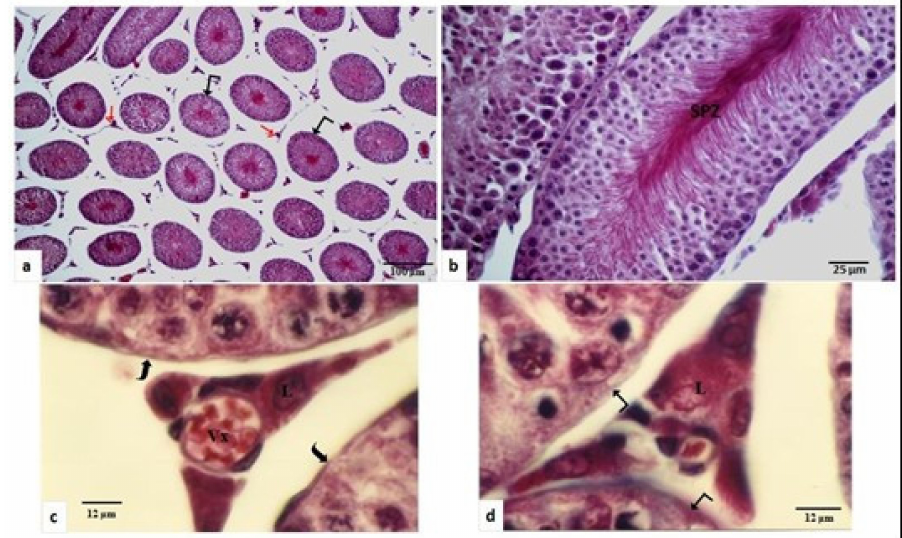
Figure 1. Testicular structure of Meriones libycus in the breeding period (spring and early summer). ( a ) Seminiferous tubules diameter ( ) is high (700 μ m ± 806 μ m) with regular outline Leyding cells ( ) are observed in the inter-tubular space. ( b ) The spermatogenesis is very active and numerous spermatozoa (SPZ) are accumulated in the lumen of the seminiferous tubule. ( c ) Leydig cells (L) are large and arranged around blood vessels (Vx), and the basement membrane ( ⊇ ) is regular, in- tact, and thin. ( d ) Leydig cells (L) are located in the vicinity of the seminiferous tubules ( ). a: ×100; b: ×400; c, d: ×1250. During the nonbreeding period (autumn), the diameter of seminiferous tubules de- creased (300 μ m ± 6.4 μ m) significantly, ( p < 0.001), and the lumen was reduced or some- times absent (Figure 2a,c). Sperm was absent and spermatogenesis was stopped at the (Figure 2a). In the inter-tubular space, very small-sized Leydig cells were grouped (Fig- ure 2b).